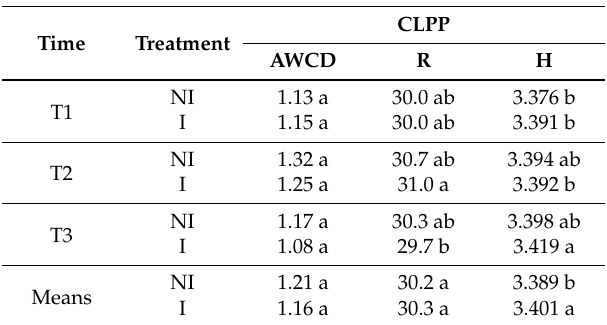
Table 1. Community Level Physiological Profiling (CLPP)